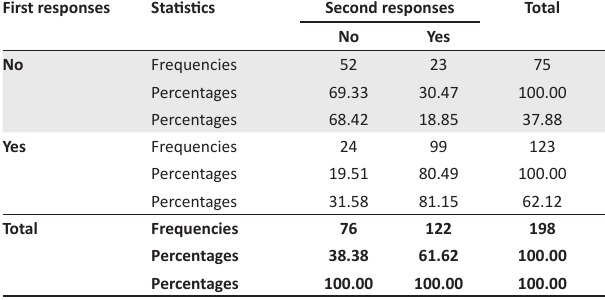
TABLE 6: Test of independence between the first and the second responses.